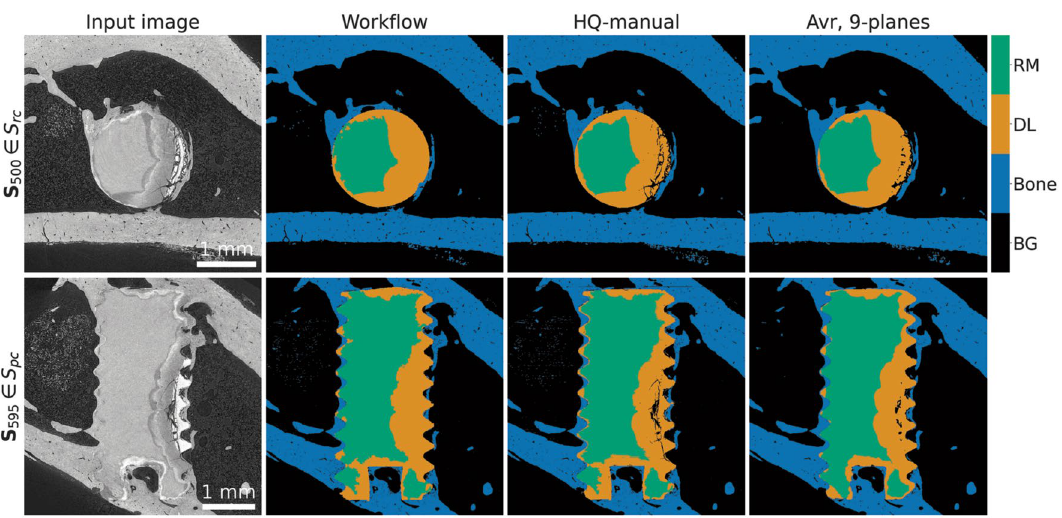
Figure 5. Comparison between different types of segmentation results—high quality (manual), workflow, and machine learning (Avr., 9-planes). We show S 500 ∈ S rc and S 595 ∈ S pc (in the first and second row, respectively) of test sample 1. For the segmentation results, the images are colored based on the corresponding label: residual material (RM), degradation layer (DL), bone, and background and S pr , but not for S rc . The inconsistency are not shown for S rc because the example shows an image in the same slicing direction. For “3-planes” and “9-planes”, we observe that these striking artifacts are increasingly reduced by multi-axes prediction fusing. We observe the same for the second example in the second row where S 470 ∈ S pc is shown. Here, the artifacts are also visible in horizontal and vertical direction for S rc and S pr , respectively. Visual and quantitative analysis of segmentation. Figure 5 shows representative slices of the image data and the corresponding segmented data sets for visual comparison. The quality of the segmentation is assessed by crack appearance in the degradation layer, the overall smoothness and accuracy in the bone struc- ture. The workflow segmentation does not give optimal results. In many regions residual material and degrada- tion layer are incorrectly detected because of the similarities in grayscale and inaccuracies in matching pixels to proper label. Moreover, the workflow segmentation does not include cracks in the degradation layer which has an effect on the quantification of the performance and on the training of the U-net. Furthermore, we compare the WF and ML segmentation to the HQ segmentation based on three important parameters: DR, BIC, and BV/TV (see Eqs. 1, 2, and 3 ). The quantified parameters based on these segmentations